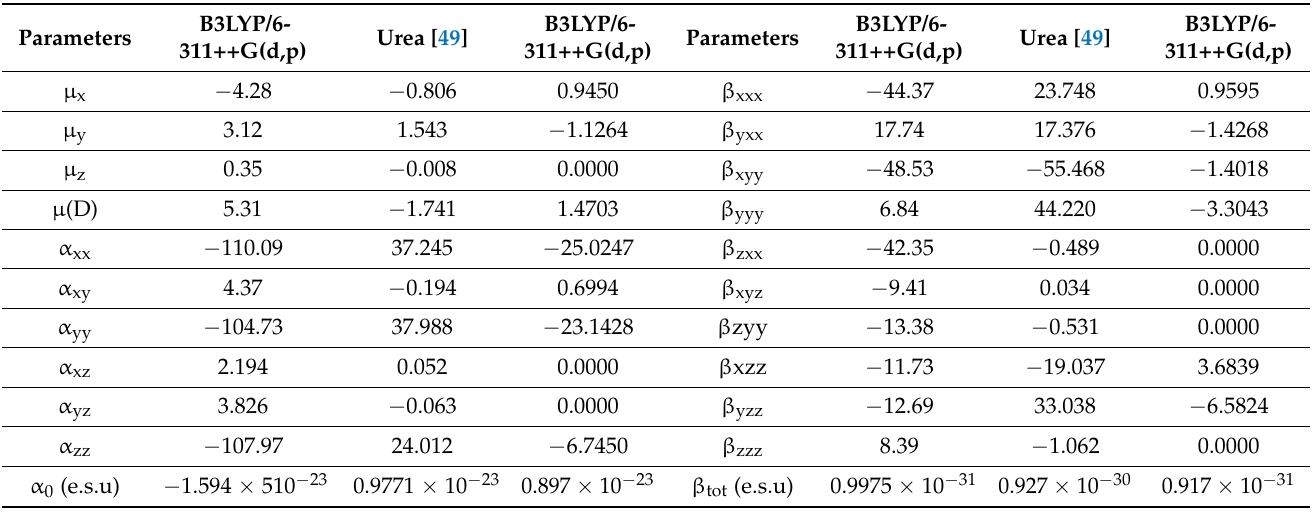
Table 2. The calculated values of dipole moment µ (D), polarizability ( α 0 ), and first order hyperpolar- izability, ( β tot ) components of